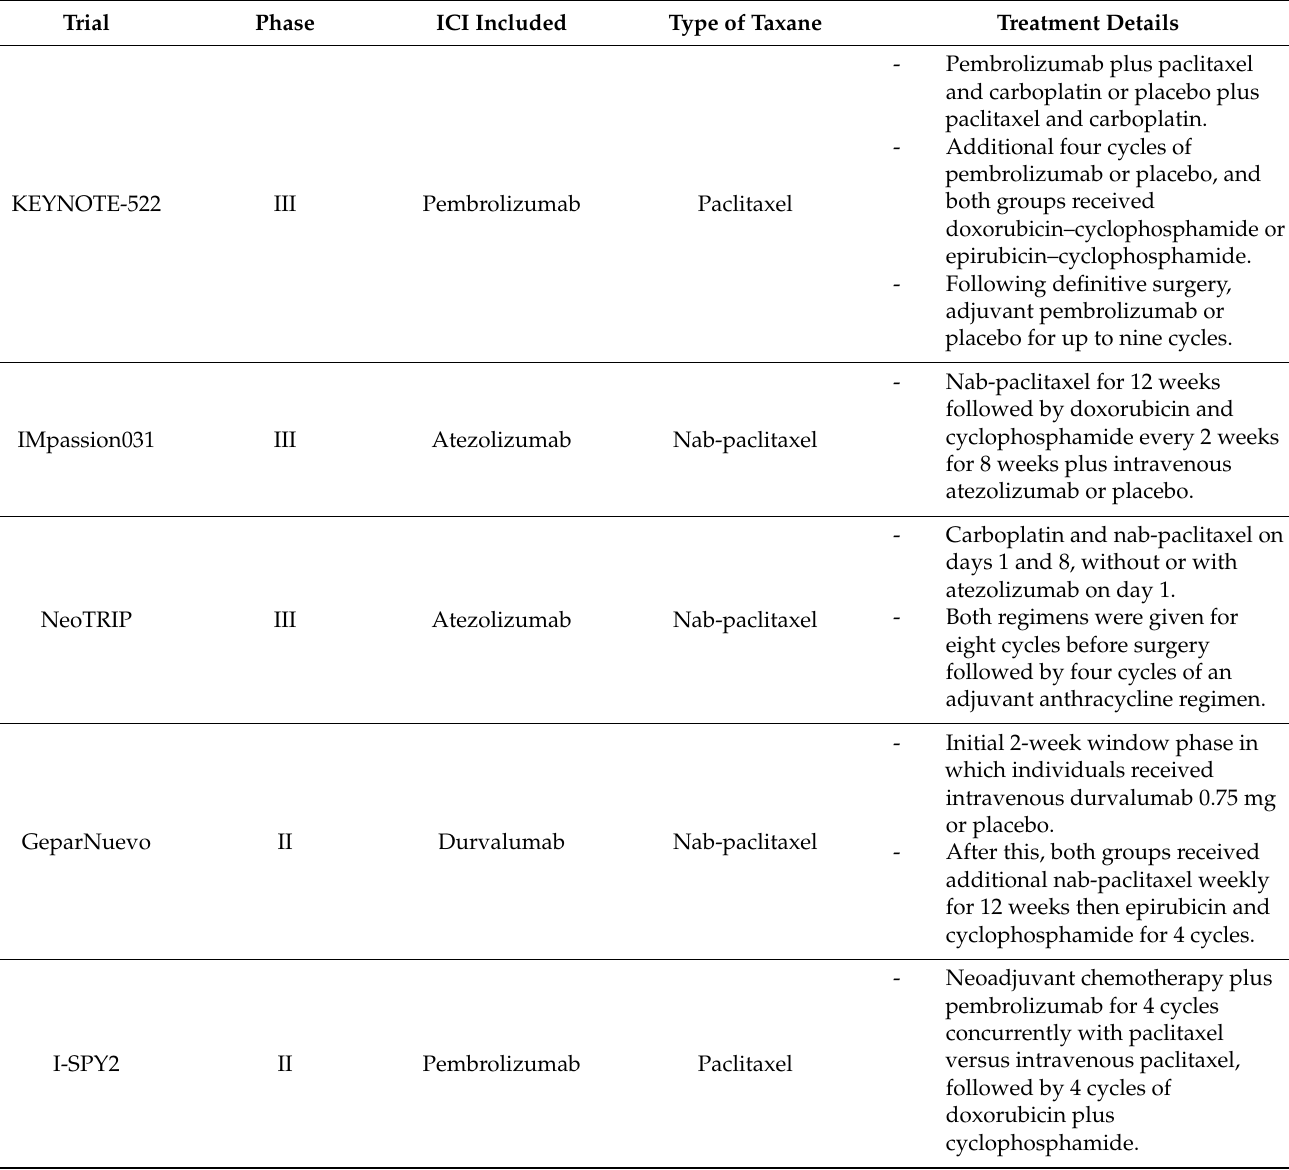
Table 1. Summary of the included studies. Abbreviations: ICI—immune checkpoint